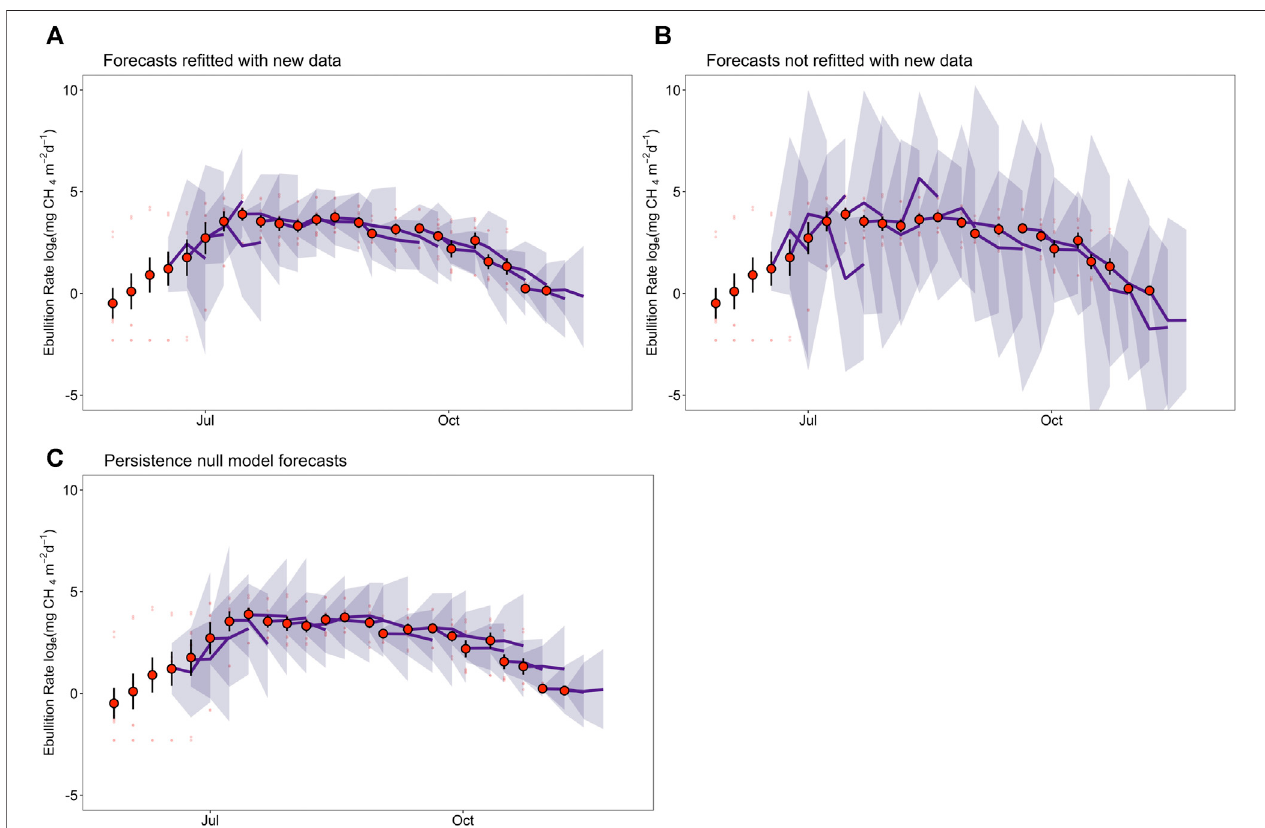
FIGURE3| Acomparison ofweeklyforecasted CH 4 ebullitionratesinlog e (mg CH 4 m − 2 d − 1 )usingawork fl owinwhichforecastmodelswereiteratively re fi ttedwith newdata (A) ,awork fl owinwhichforecastswerenotre fi ttedwithnewdata (B) ,andapersistencenullmodel (C) from17JunetoNovember7,2019.Thelargeredcircles plus black error bars represent the observed daily mean transect CH 4 ebullition rate ± 1 standard error of the mean from four ebullition traps depicted in Figure 1 . The small red circles represent the measured CH 4 ebullition rate from each ebullition trap on the transect. The dark purple lines represent the forecasted mean daily ebullition rate from the posterior predictions. The purple shades represent the 95% predictive intervals of the forecasts.